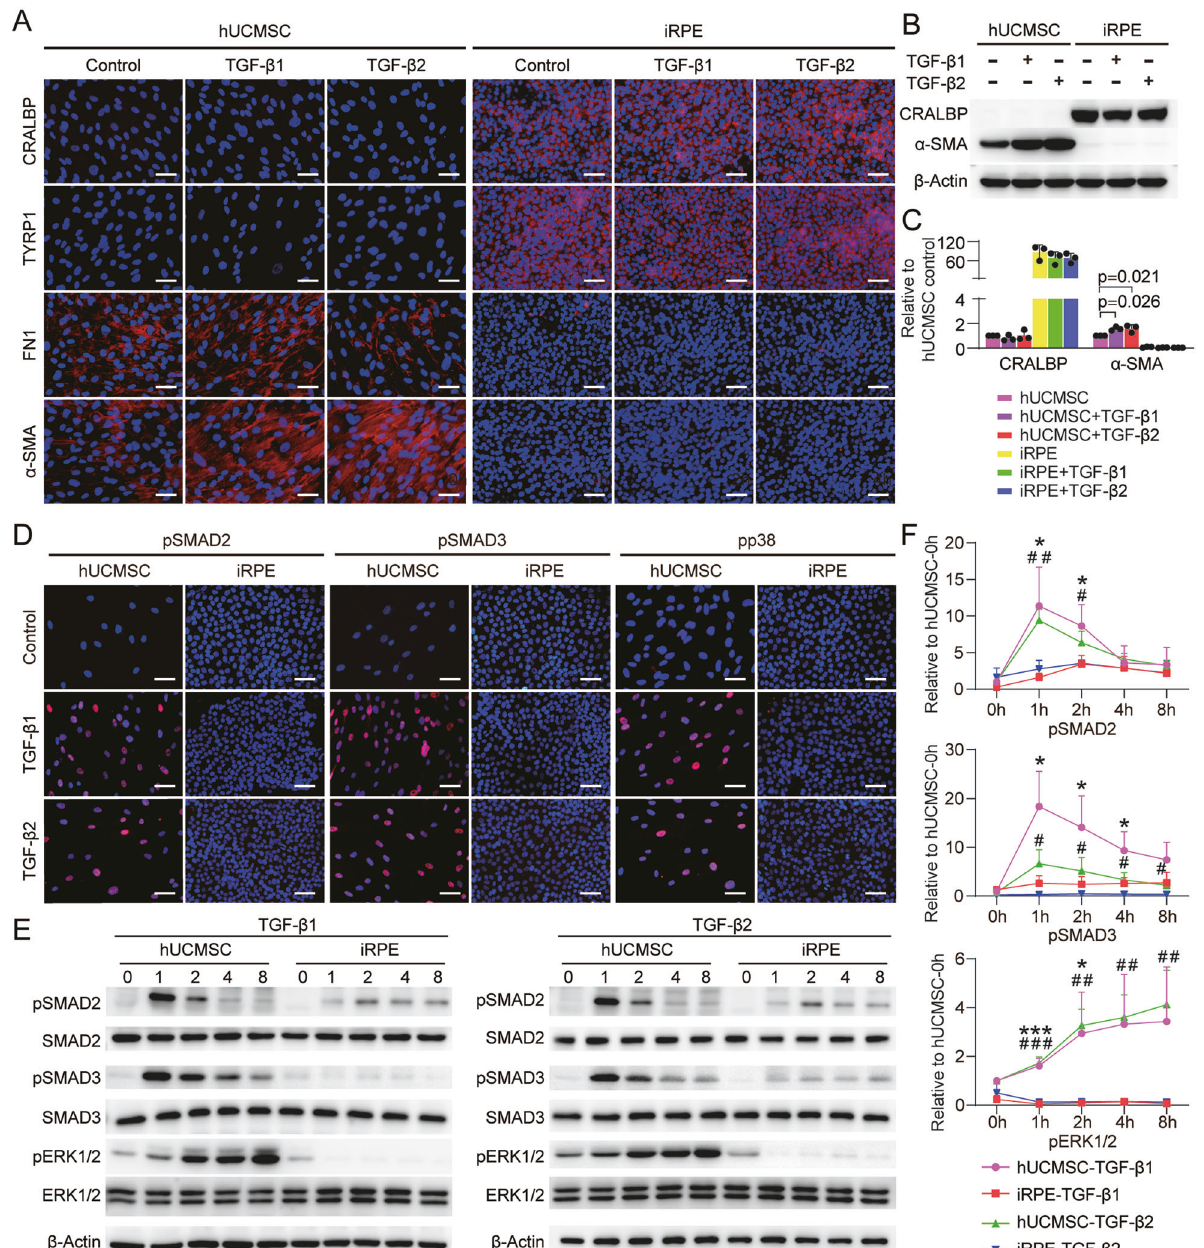
Fig. 3 iRPE cells possess anti-EMT property. RPE-speci fi c and EMT-associated markers in hUCMSCs and iRPE cells stimulated with TGF- β 1 or TGF- β 2 were detected by A immunostaining, B Western blotting, and C quantitative analysis ( n = 3). The phosphorylation of SMAD2/3, p38, and ERK1/2 in hUCMSCs and iRPE cells stimulated with TGF- β were detected by D immunostaining, E Western blotting, and F quantitative analysis ( n = 3). Scale bar = 50 μ m. Results are expressed as mean ± SD. * P < 0.05, *** P < 0.001, hUCMSC-TGF- β 1 compared with iRPE-TGF- β 1; # P < 0.01, ## P < 0.01, ### P < 0.001, hUCMSC-TGF- β 2 compared with iRPE-TGF- β 2. Results are expressed as mean ± SD. P value measured by one- way ANOVA and post hoc Bonferroni ’ s